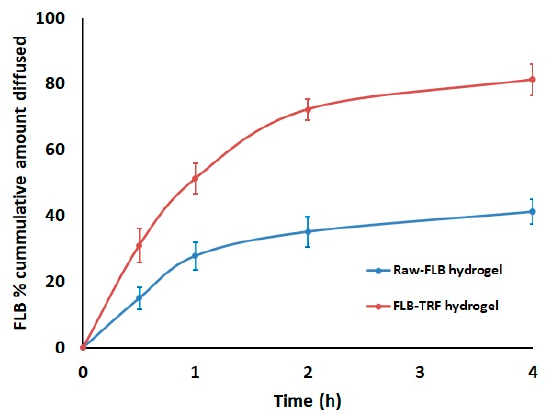
Figure 4. Ex vivo permeation profile of optimized FLB-TRF-loaded intranasal hydrogel compared to raw FLB hydrogel in simulated nasal fluid, pH 6.5, at 35 °C (results presented as mean ± SD, n = 3).